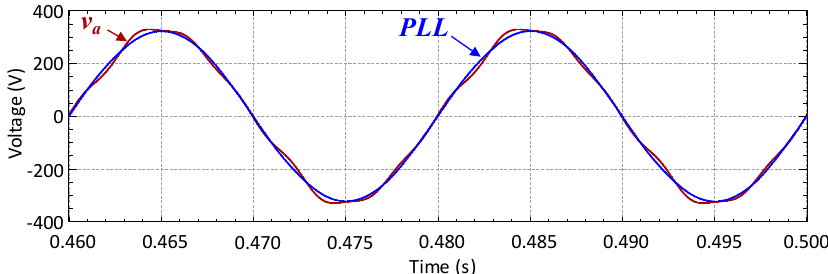
Figure 22. Simulation results of the synchronism detail between the power grid voltage and the PLL output.